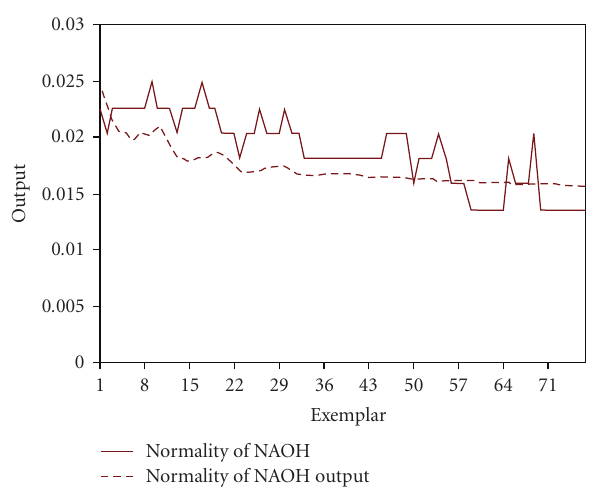
Figure 5: Desired output and Network output for testing data set (Fully recurrent NN model-Lab. data).